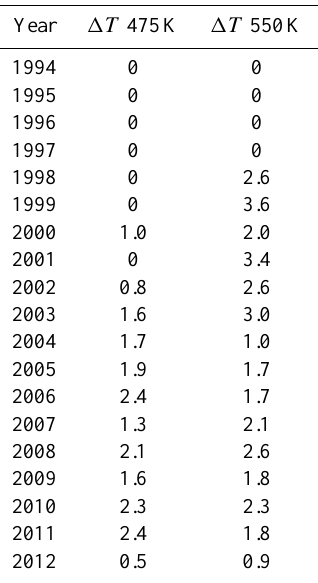
between 400-675 K PSC inside vortex; Right: sunlit V only, PSC PSC instead of total V PSC PSC was similar or larger in 1996 than in PSC